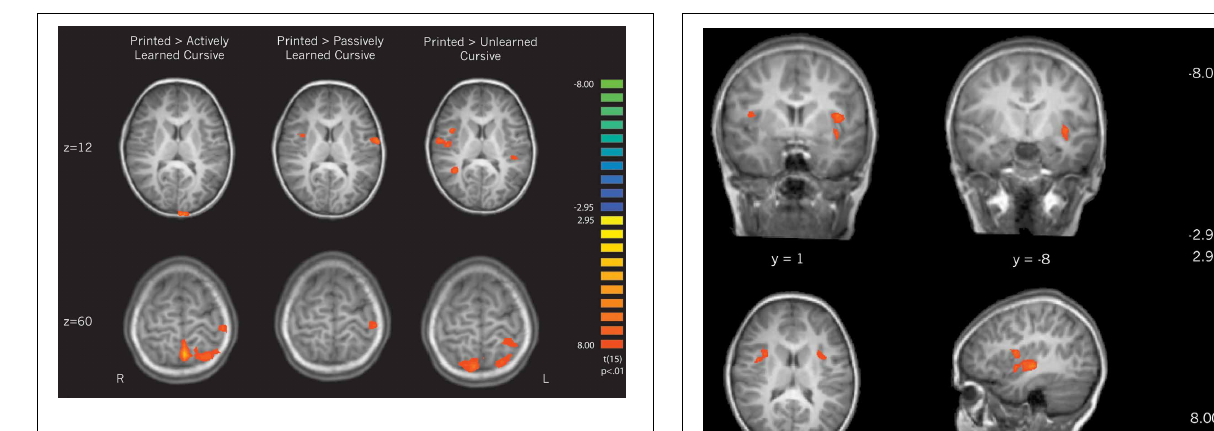
FIGURE 5 | Direct contrasts of perception of printed letters > perception of cursive letters broken down by cursive learning condition. The upper slice denotes of pattern of interest regarding the right insula, which is recruited when printed letters are compared only to passively learned and unlearned cursive. The bottom slice reveals greater recruitment of motor regions for printed letters in comparison to each type of cursive letter.